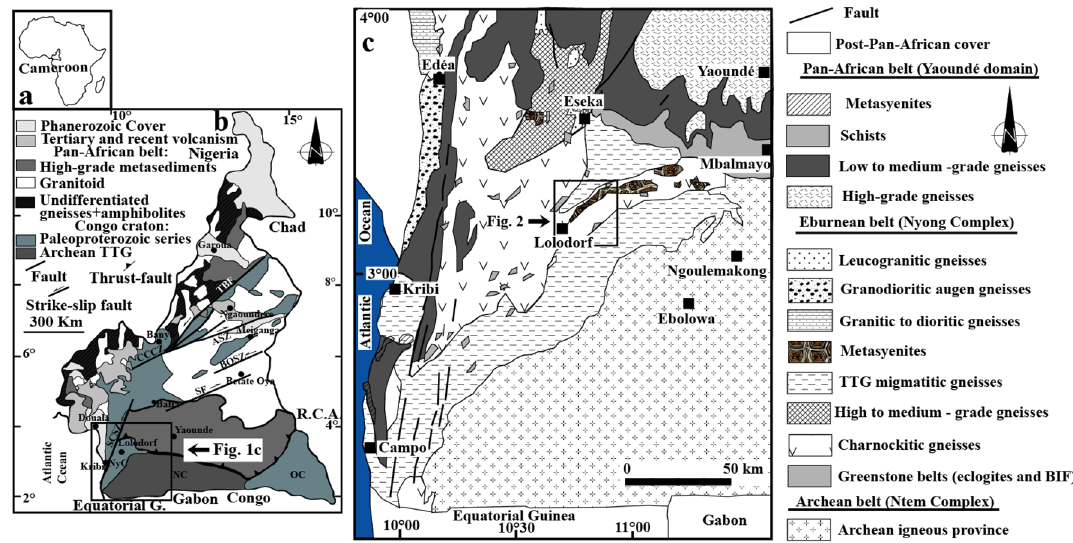
Fig. 1 a Map of Cameroon in central Africa; b Geological sketch map of Cameroon modified after [33]; c Geological sketch map of the south- western Cameroon modified after